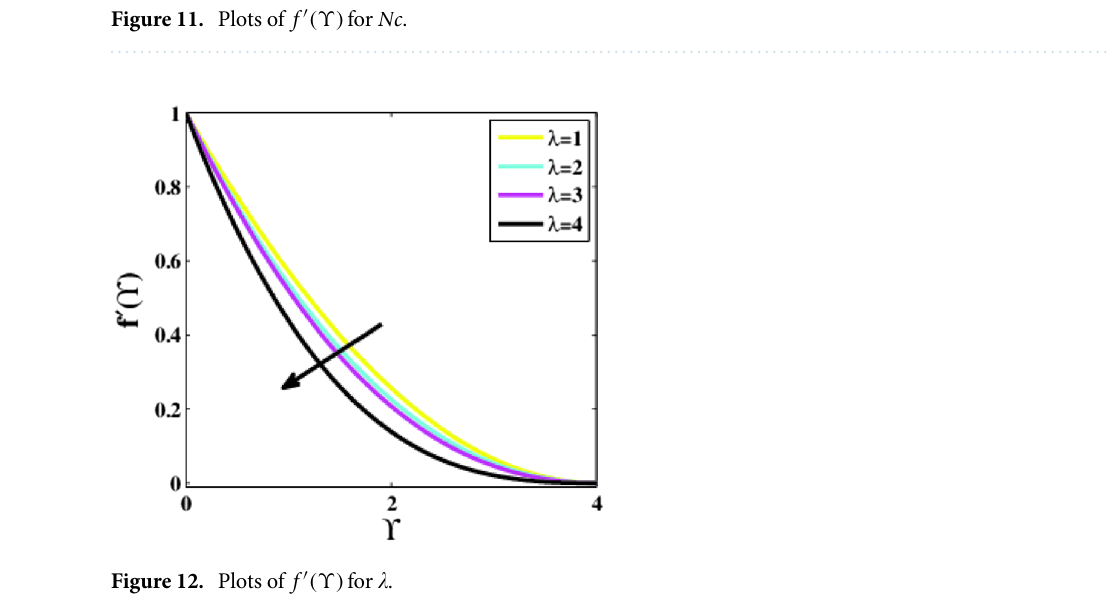
Figure 11. Plots of f